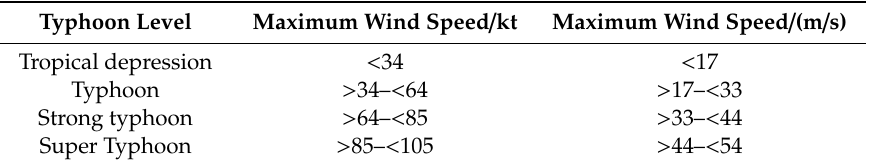
Table 1. Typhoon level standard label.